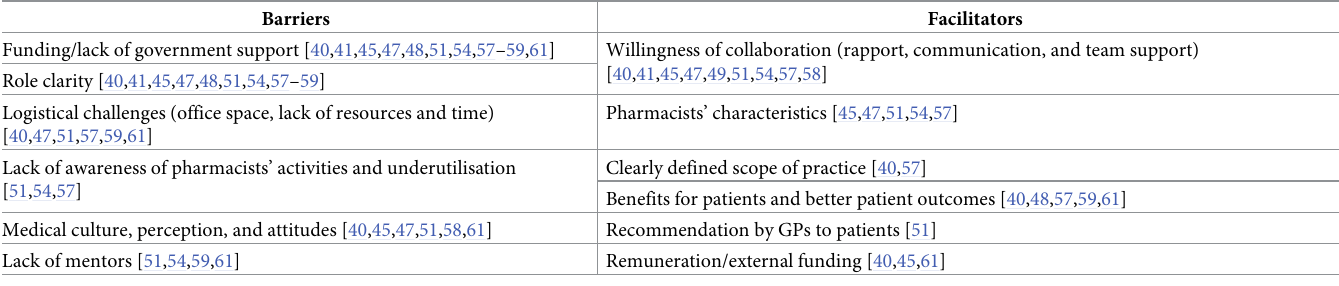
Table 2. Barriers and facilitators for the inclusion of general practice pharmacists in Australia. Barriers